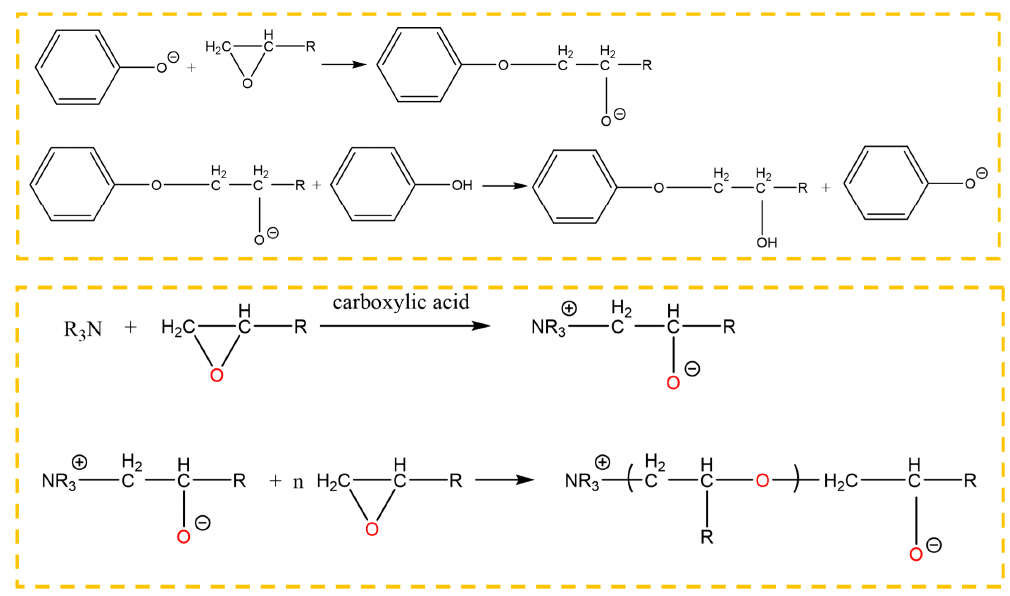
Figure 15. Reaction between 2,4,6-tris (dimethylaminomethyl) phenol and the epoxy group.